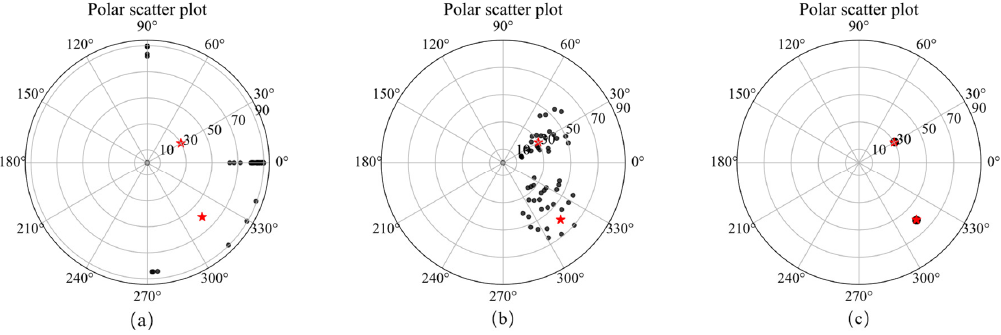
Figure 12. Polar scatter plots showing inverted magnetic inclination (radial) and declination (axial) of method 1 ( a ), method 2 ( b ) and method 3 ( c ) and the ground truth (red stars). Table 5 shows the scores of the three inversion results of dual models by S IOU , S RMSE and S IRE . It shows that the inversion effect by the method proposed in this paper is best. The conclusions drawn from the evaluation indexes are consistent with the results observed by the inversion